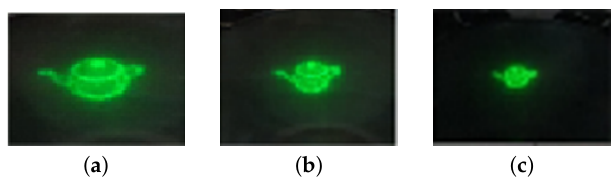
Figure 12. Result of zoom in and out gestures. ( a ) Zoom in; ( b ) Default state; ( c ) Zoom out.